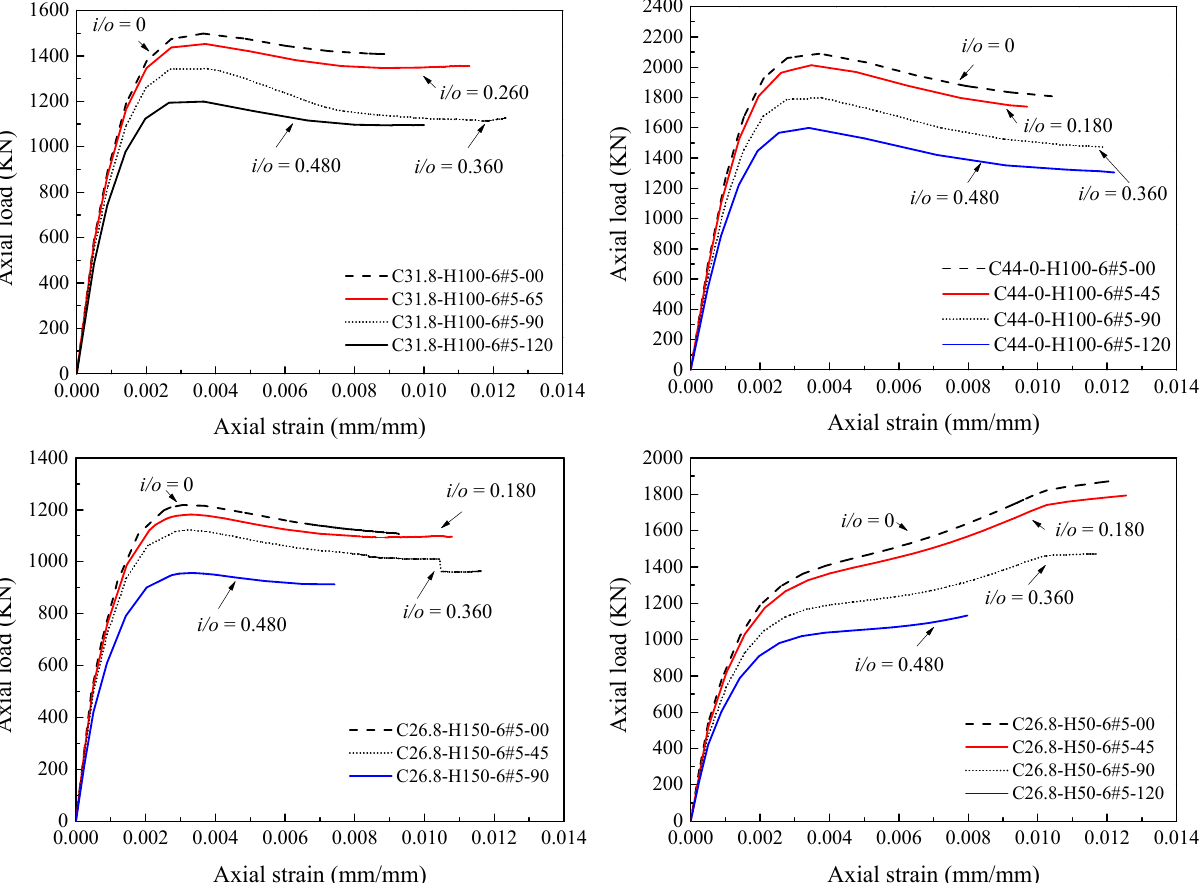
Figure 23. Effect of different inner-to-outer ( D i / D ) diameter ratios on the load-strain response of HCCs.